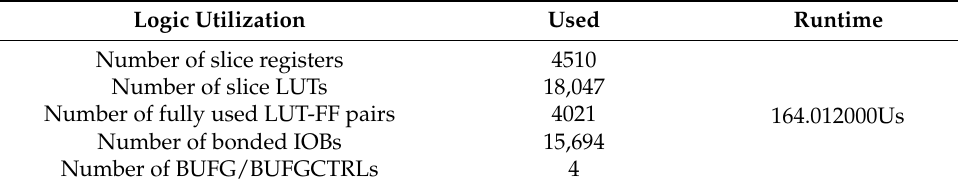
Table 1. Device utilization summary (estimated values).